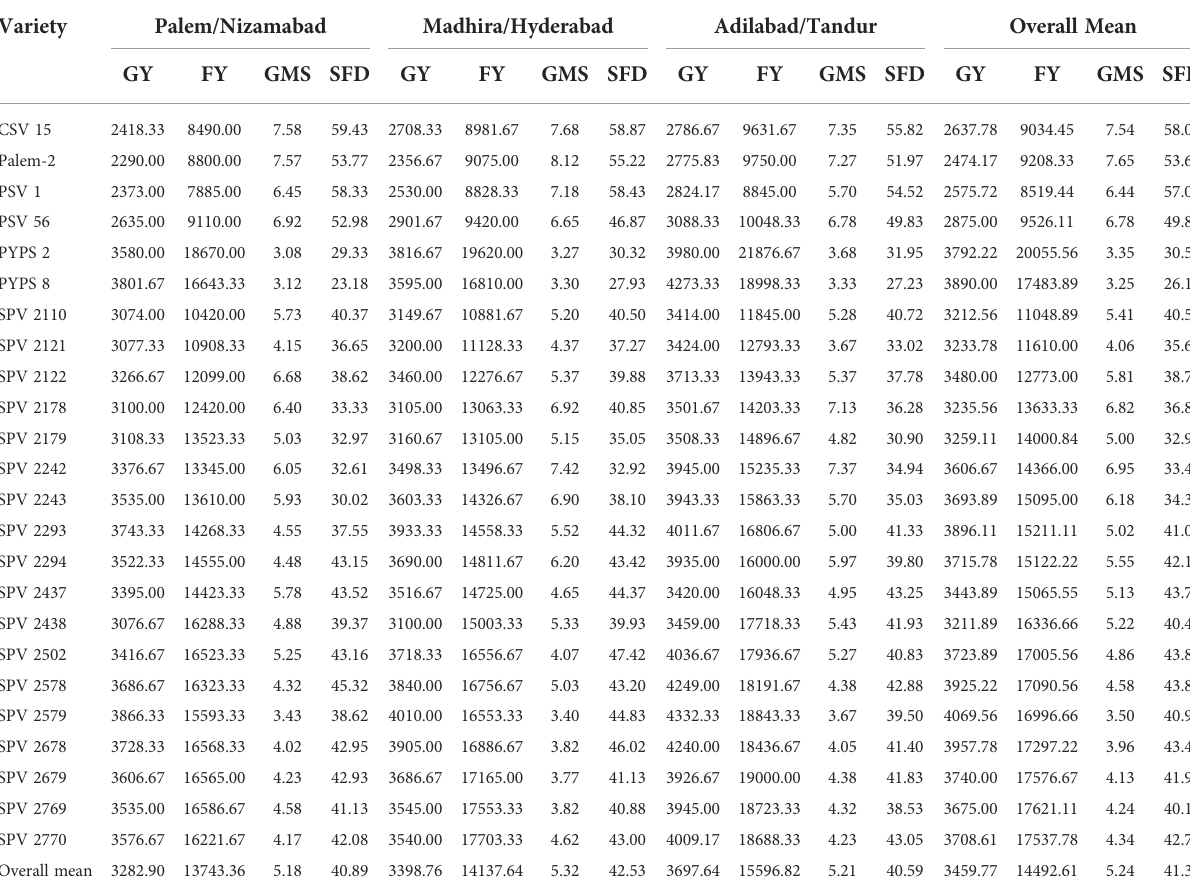
TABLE 4 Mean performance of sorghum varieties for grain yield, fodder yield, grain mold score and shoot fl y damage tested in three environments during 2018-2020.